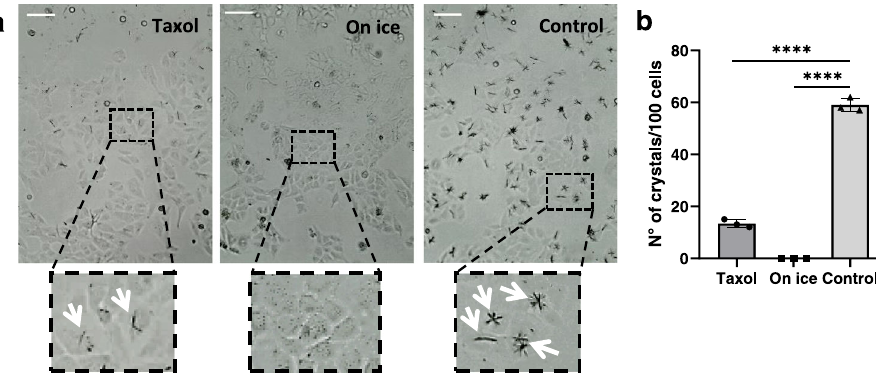
Fig. 3 Formation of QPD crystals in U2OS live cells is disrupted by induced microtubule stabilization or depolymerization. a Representative images of crystal formation in cells treated (left) with 1 µ M Taxol for 1h and 20 µ M QPD-OTf for 4h at 37°C; (middle) on ice for 1h and with 20 µ M QPD-OTf for 4h on ice; and (right) with 20 µ M QPD-OTf for 4h at 37°C. (Bottom) Zoomed-in images of cells in the black squares; white arrows indicate crystals. Scale bar 100 µ M. b Quanti fi cation of the number of crystals for conditions reported in a ; n = 100; data are presented as mean value± the standard deviation (SD); data are the average of three independent experiments; Statistics were calculated using a two-tailed t -test; **** p <0.0001. Source data are provided as Source Data